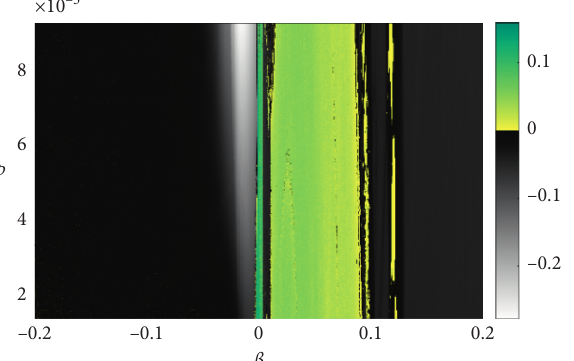
Figure 2: Lyapunov exponent in 2D with r � 0.1, a � 1.6, b � 0.05, c � 0.35, d � 4/27, e � 0.0001, Γ � 0.2, p ∈ [0.001: 0.009], Ω � 1.0, and β ∈ [ − 0.1 :0.25].